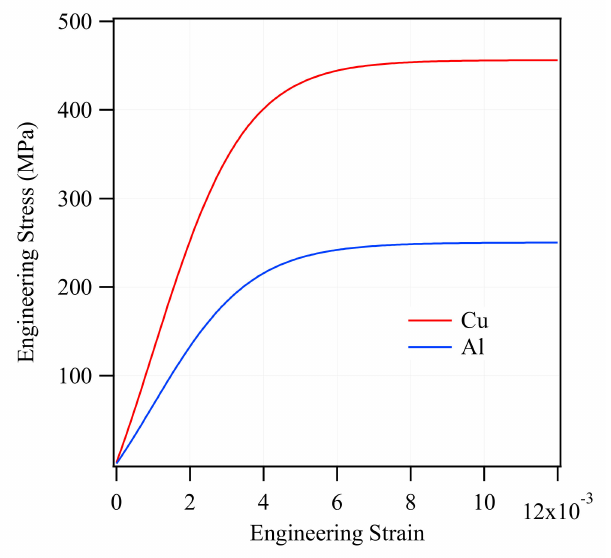
Figure 2. Experimental engineering stress-strain curves of pure copper and aluminum